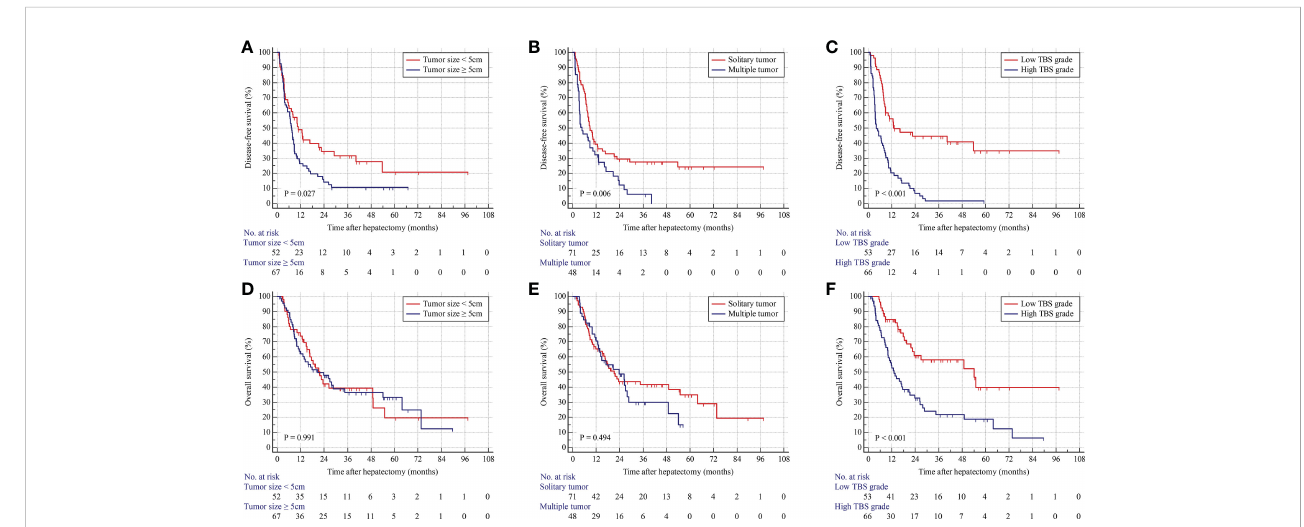
FIGURE 2 Kaplan – Meier curves for DFS and OS strati fi ed by tumor size (A, D) , tumor number (B, E) , and TBS grade (C, F) in the derivation cohort.